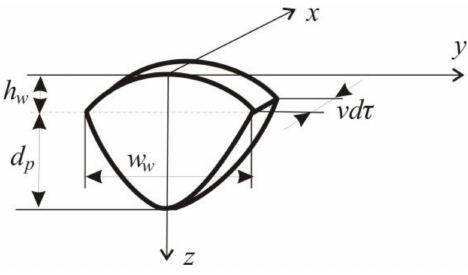
Figure 2. Padding weld